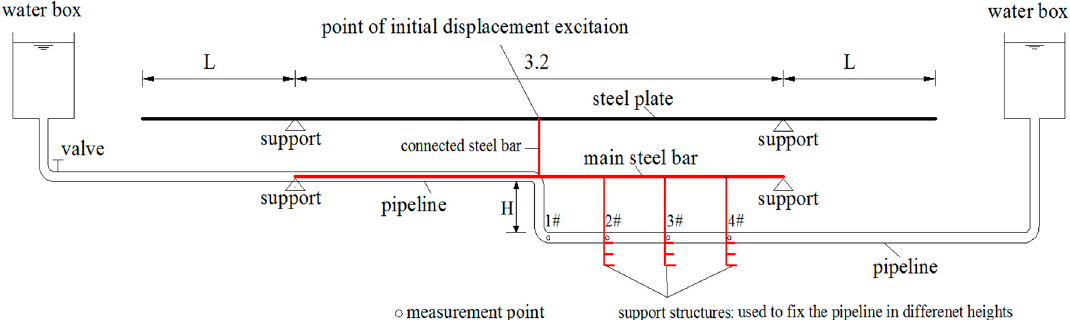
Figure 10. Design layout of the test model and step-type LLSS (unit: m).